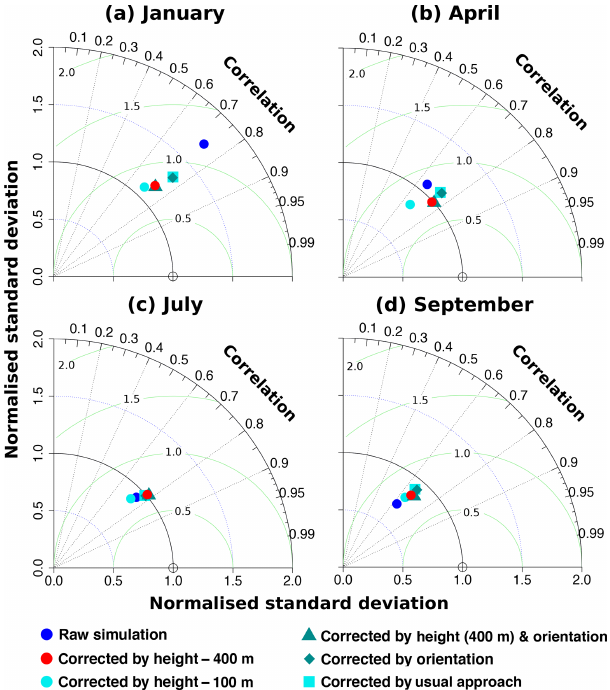
Figure 10. Performance of bias correction with different settings. Panel (a) shows a Taylor diagram for January, (b) for April, (c) for July, and (d) for September. Blue dots represent the raw simula- tion, red dots the simulation corrected by using height intervals of 400m, cyan dots the simulation corrected by using height intervals of 100m, petrol triangles the simulation corrected by using height intervals of 400m and slope orientations, petrol diamonds the sim- ulation corrected by slope orientations, and cyan squares the sim- ulation corrected by the simple approach (the entire Swiss region). Note that in the Taylor diagram the spatial correlation, spatial root- mean-square error, and spatial standard deviation are